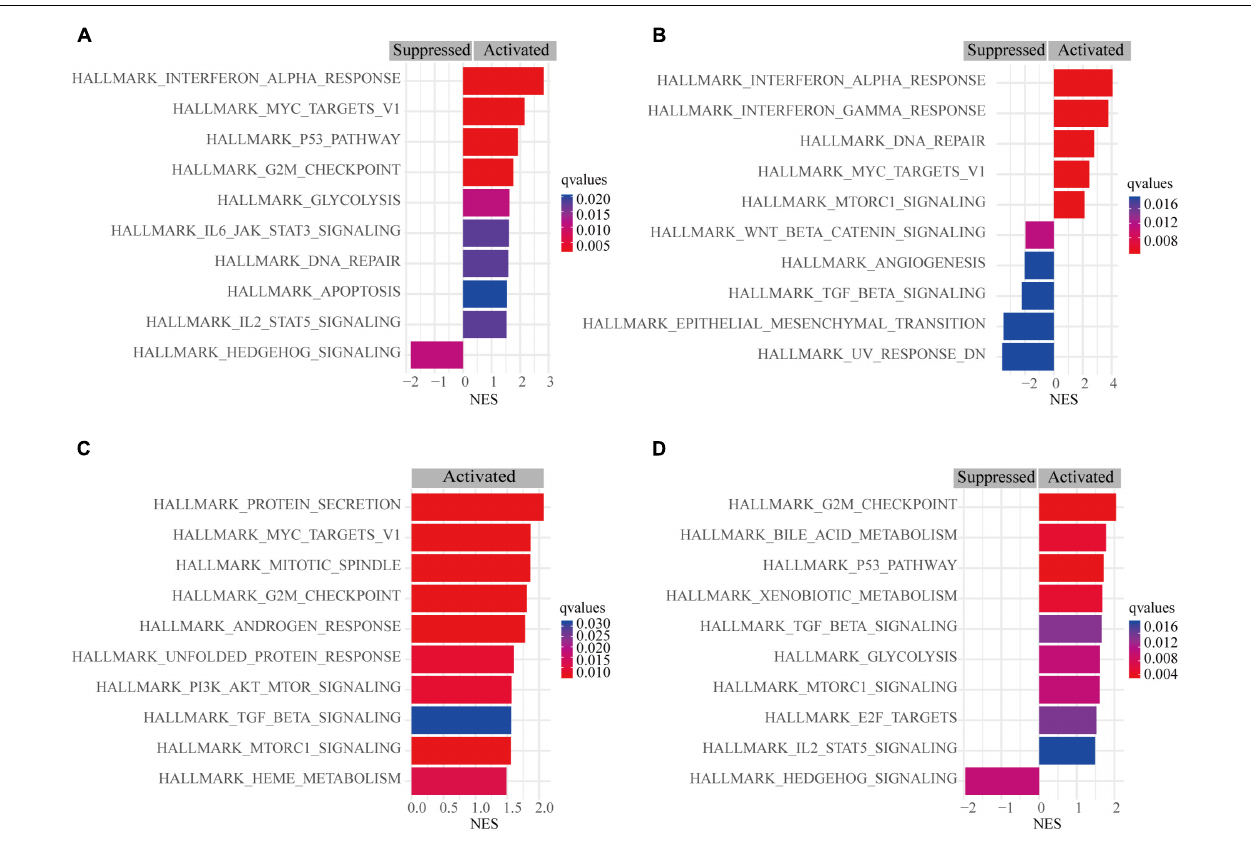
FIGURE 9 | Gene set enrichment analysis (GSEA) of PSME genes in GC. (A) PSME1. (B) PSME2. (C) PSME3. (D) PSME4. NES, normalized enrichment score. Only the 10 most common functional pathways enriched were listed. q -values were adjusted P -values and was set at